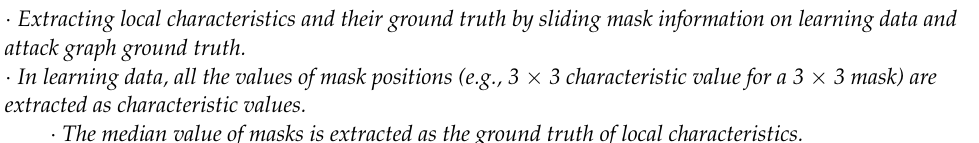
Algorithm 1. Extraction algorithm of network local-information-based attack graph characteristics.